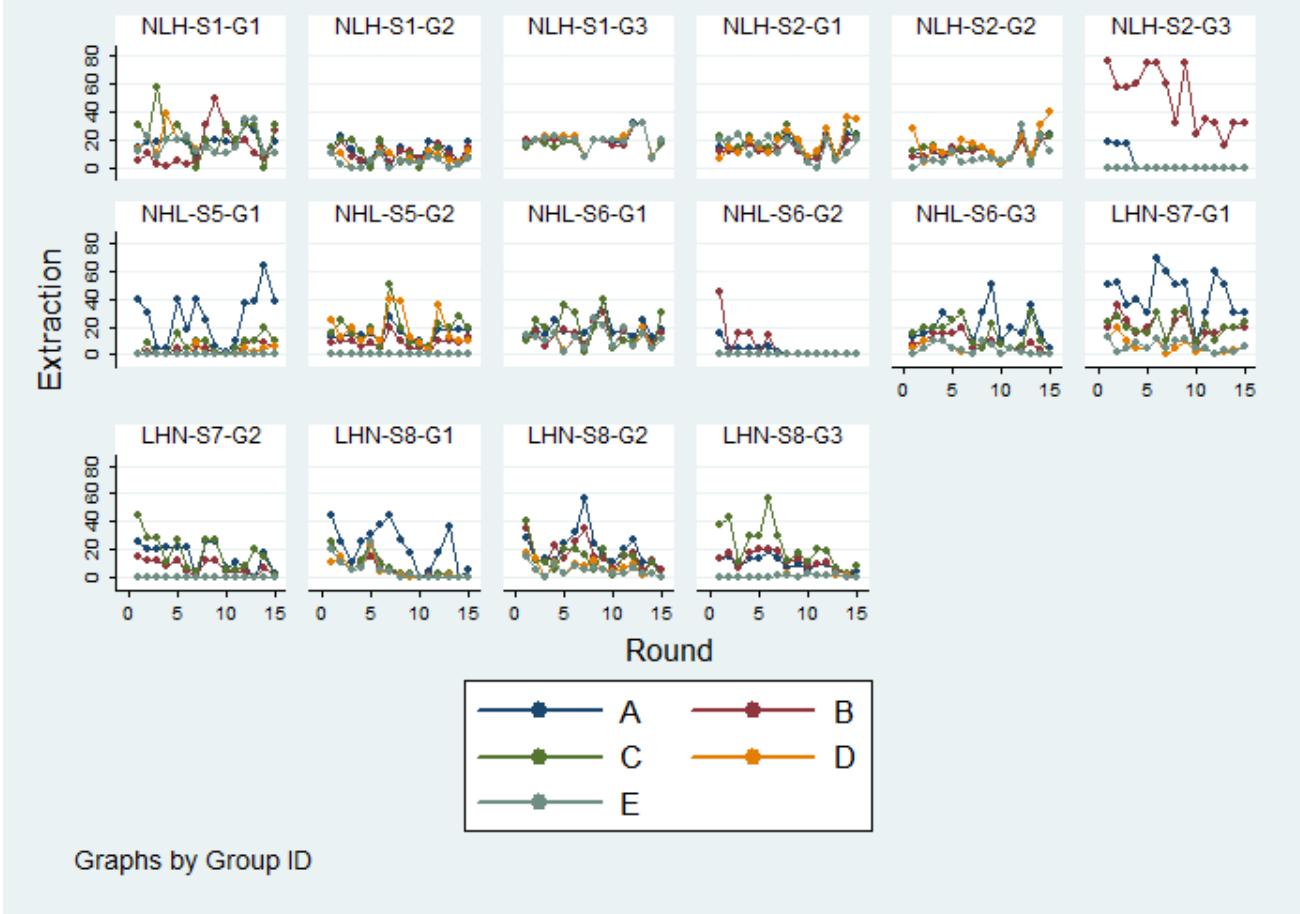
Figure S2: Extraction per group per position. Each group is preceded by the treatment label (NLH = no, low and high Variability, NHL = no, high and low Variability; LHN = low, high and no